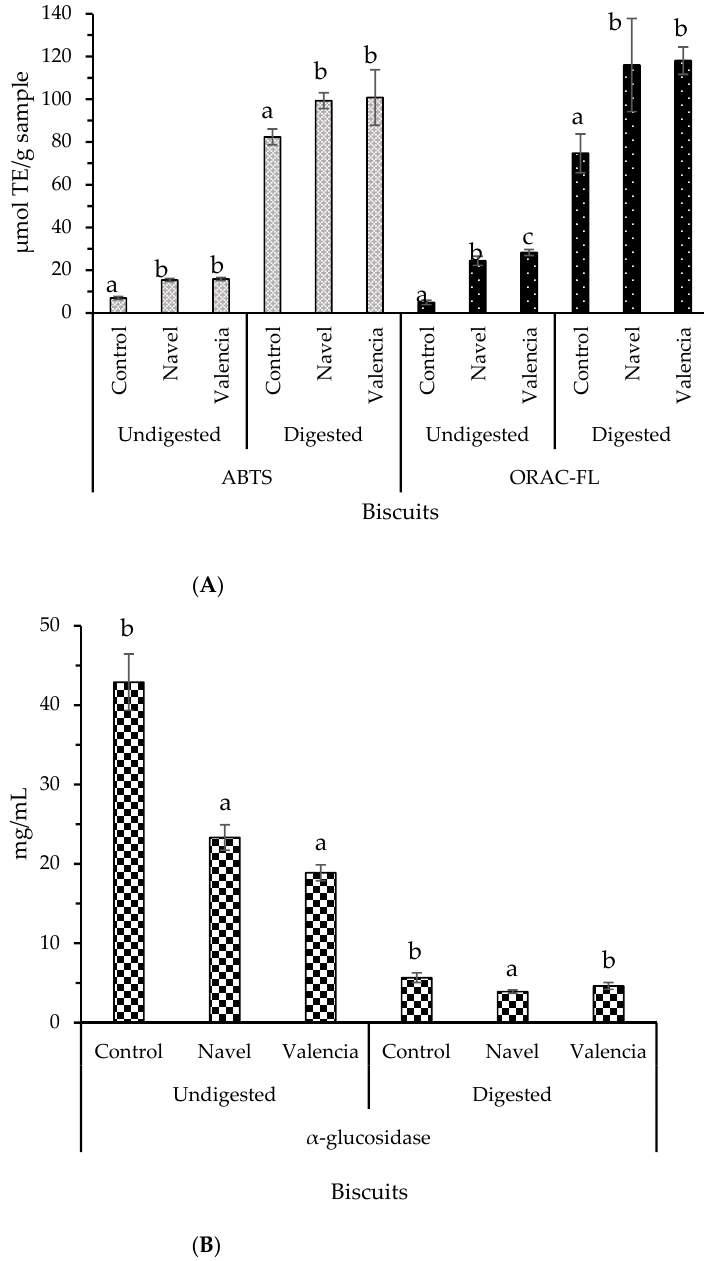
Figure 5. ( A ) Antioxidants and ( B ) inhibitors of α -glucosidase composing biscuits based on orange pomaces and their bioaccessible fractions. Bars represent mean values while error bars represent the standard deviation ( n = 3). Different letters (a, b and c) indicate significant differences (Tukey, p < 0.05) between values in each set of six samples, where sets of samples are undigested ABTS samples, digested ABTS samples, undigested ORAC-FL samples, digested ORAC-FL samples, undigested α -glucosidase samples, and digested α -glucosidase samples.